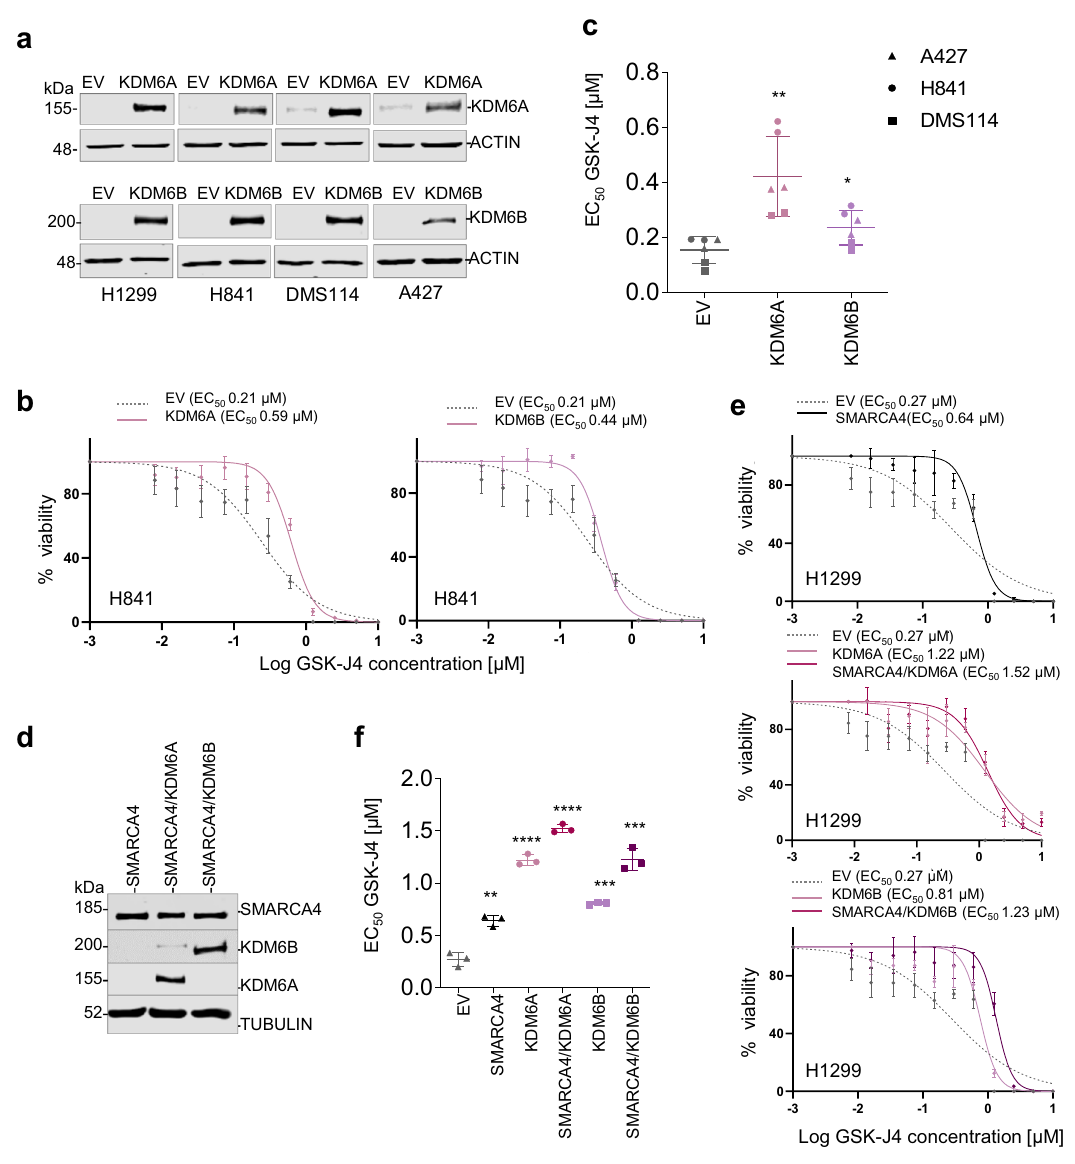
Fig. 5 Overexpression of KDM6s reverts sensitivity to KDM6s inhibition. a Western blot depicting levels of ectopic KDM6s and KDM6B in the indicated SMARCA4def cells overexpressing the indicated proteins. EV Empty vector. b Example of viability of H841 cell line, measured using MTT assays, 5 days after treatment with increasing concentrations of GSK-J4. Lines, number of viable cells relative to the untreated cells. Data are presented as mean ± SD from three replicate cell cultures in two experiments. EC 50 , half-maximal effective concentration . c Distribution and mean of the EC 50 from two independent experiments per each of the three LC cell lines. Lines show mean ± SD. P -values were calculated using paired two-tailed Student ’ s t test. ** P = 0.0017; * P = 0.031. d Western blot depicting levels of KDM6s and SMARCA4 in the H1299 cells overexpressing the indicated proteins. e Viability of indicated cell lines, measured using MTT assays, 5 days after treatment with increasing concentrations of GSK-J4. Lines, number of viable cells relative to the untreated cells. Data are presented as mean ± SD from three replicate cell cultures in two experiments. f Distribution and mean of the EC 50 from three independent experiments. Lines show mean ± SD. P -values were calculated using paired two-tailed Student ’ s t test. ** P = 0.0016; *** P = 0.0002; **** P < 0.0001; A Source Data fi le is available for this fi gure.